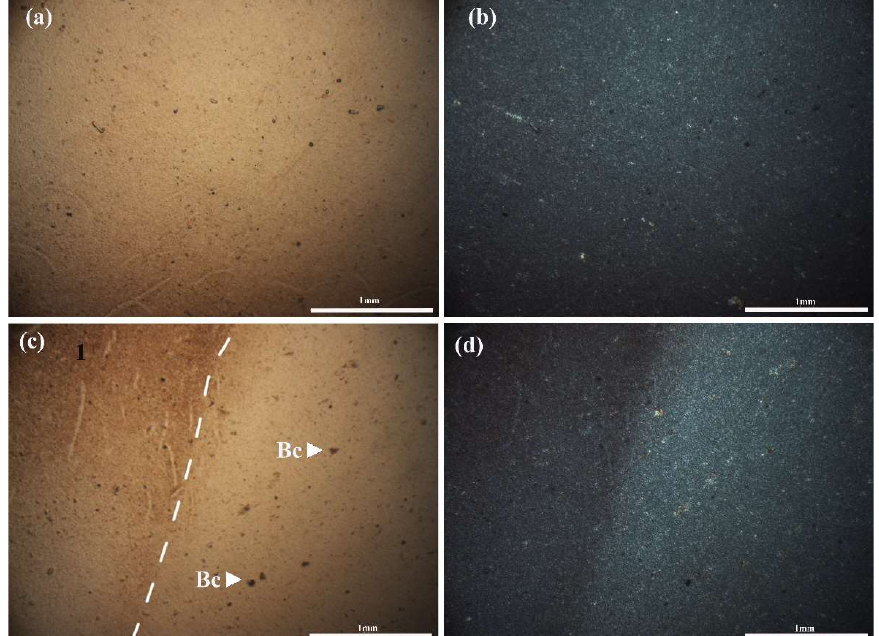
Figure 7. Photomicrographs of MB1a microstructures in ( a , b ) plane (PPL) and ( c , d ) cross polarized light (XPL) (Bc: bioclast, 1: micro-area impregnated with iron oxides).